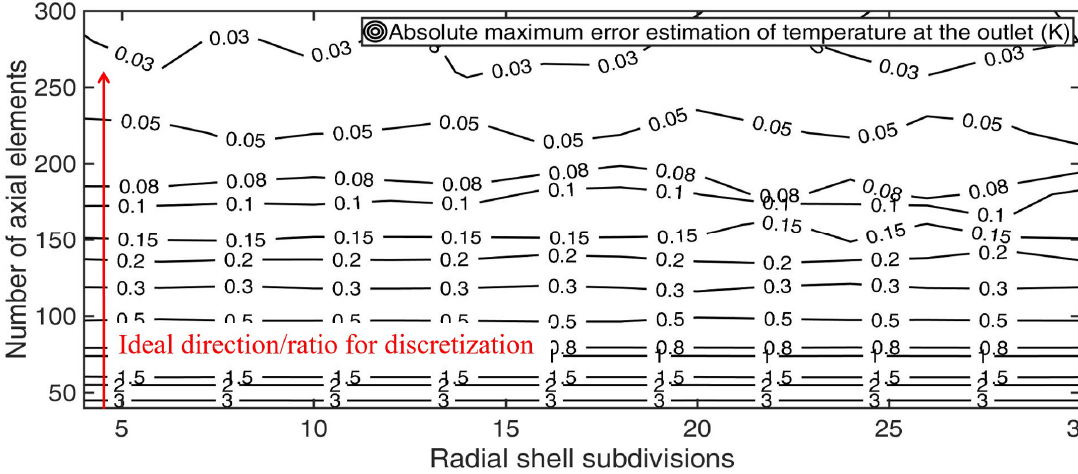
Figure 18. Computation times of the composite model tests (Case 1).